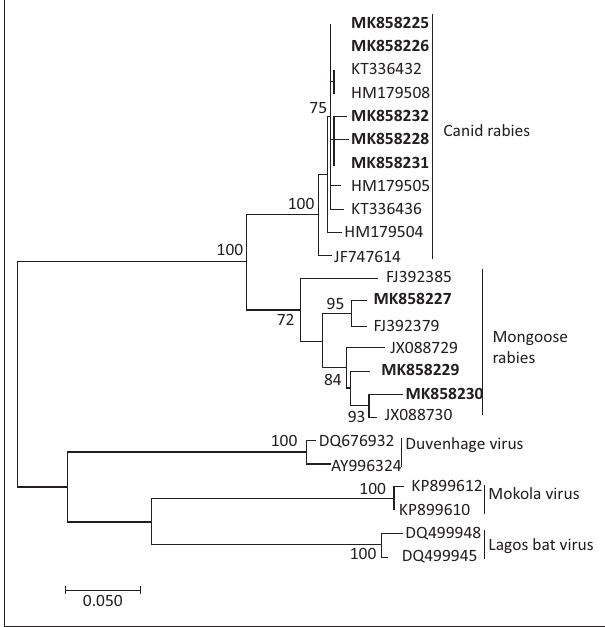
FIGURE 2: Maximum likelihood phylogenetic reconstruction of partial rabies nucleocapsid gene sequences from eight human rabies cases resulting from cat exposures in South Africa (indicated in boldface) and other Genbank sequences representing rabies-related and lyssavirus variants. Node values indicate bootstrap statistical